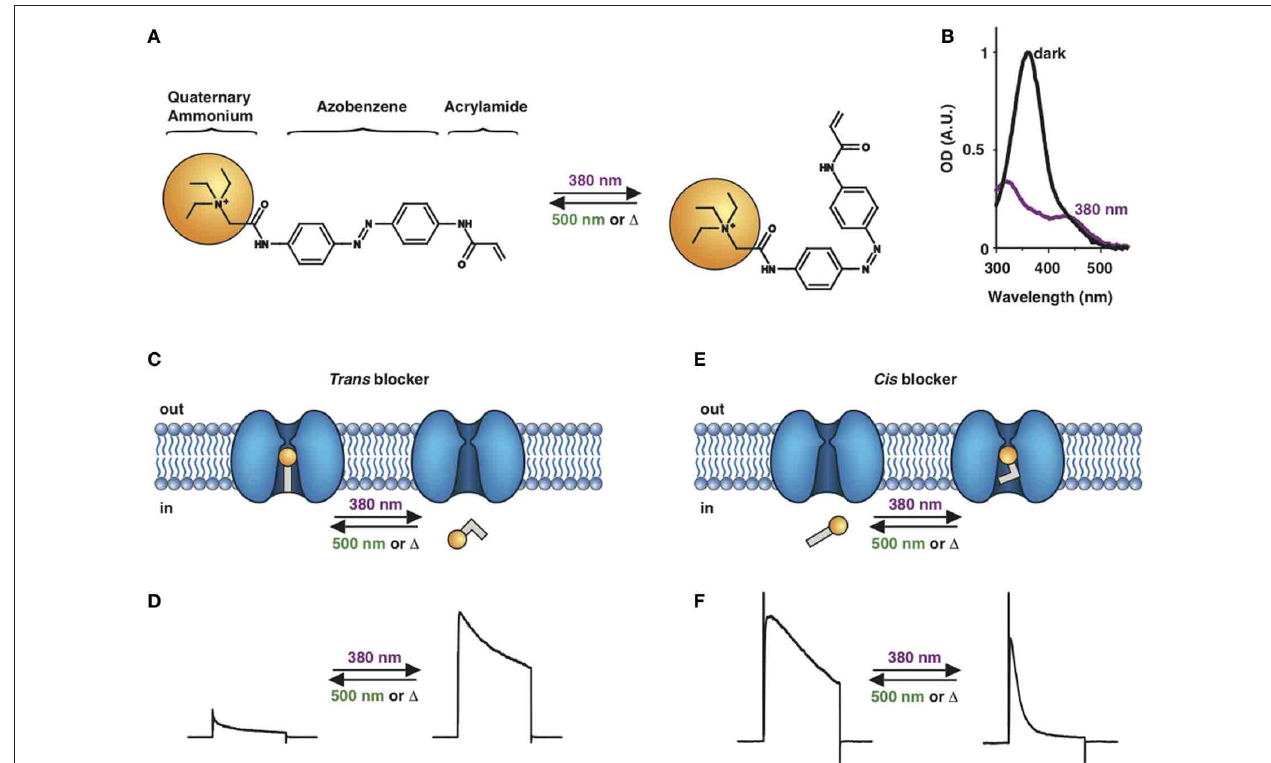
FIGURE 1 | Photoswitchable blockers for voltage-gated potassium channels. (A) Chemical structures of trans (left) and cis (right) AAQ (Acrylamide-Azobenzene-Quaternary ammonium). The quaternary ammonium moiety (ligand) is highlighted by a yellow sphere. (B) Absorption spectrum of QAQ (Quaternary ammonium-Azobenzene- Quaternary ammonium) in the dark ( ∼ 100% trans ) and during illumination with 380nm light (mostly cis ). (C) Scheme of a trans blocker. The blocker binds to the intracellular vestibule and blocks ion conduction through voltage-gated potassium channels in the trans configuration (500nm light or darkness) but not after photoisomerization